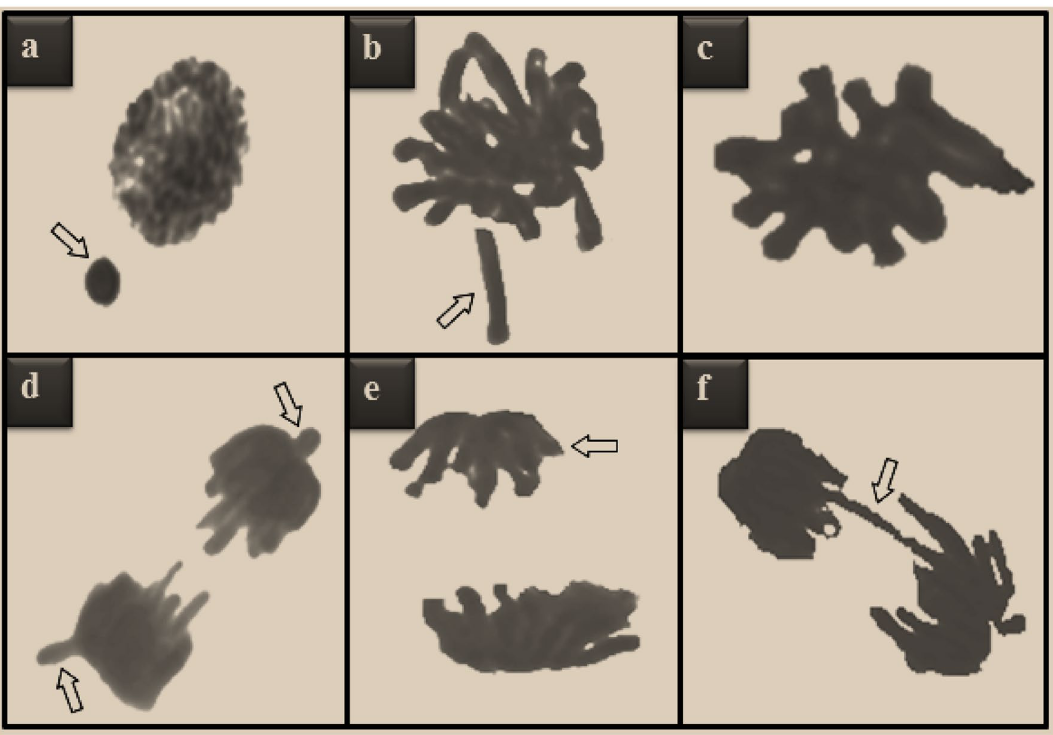
Figure 3. CAs types induced by MnCl 2 toxicity. MN ( a ), fragment ( b ), sticky chromosome ( c ), vagrant chromosome ( d ), unequal distribution of chromatin ( e ), bridge ( f ).